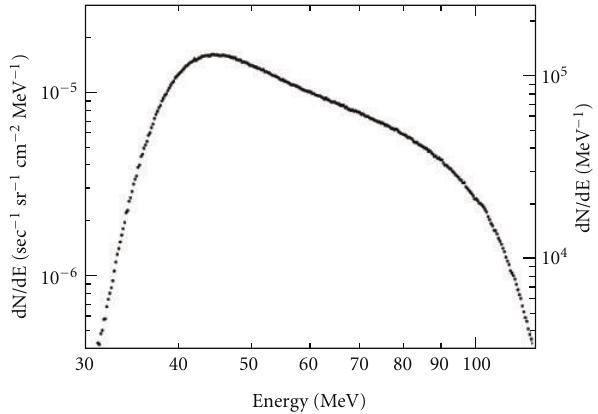
Figure 7: Energy spectrum of protons recorded in the FIB sensor during January 1–July 31, 2010. The data obtained over the SAA region is unrelated to this data. The left side axis represents the di ff erential flux of neutron-induced protons denoted by the unit of (/sec · sr · cm 2 · MeV).